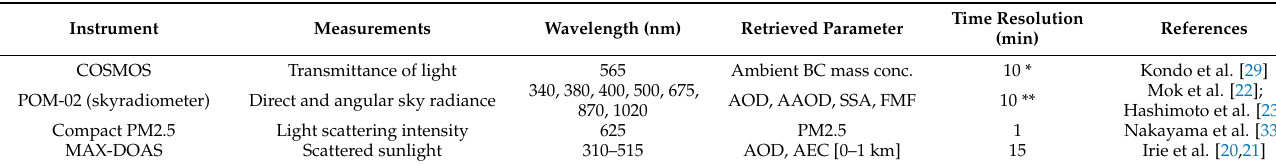
Table 1. List of instruments used at Chiba University from 12 November 2019, to 31 December 2020, and the associated retrieved datasets used in this study. Acronyms: black carbon (BC), aerosol optical depth (AOD), absorption aerosol optical depth (AAOD), single scattering albedo (SSA), fine-mode fraction (FMF), aerosol extinction coeffiocient (AEC), planetary boundary layer height